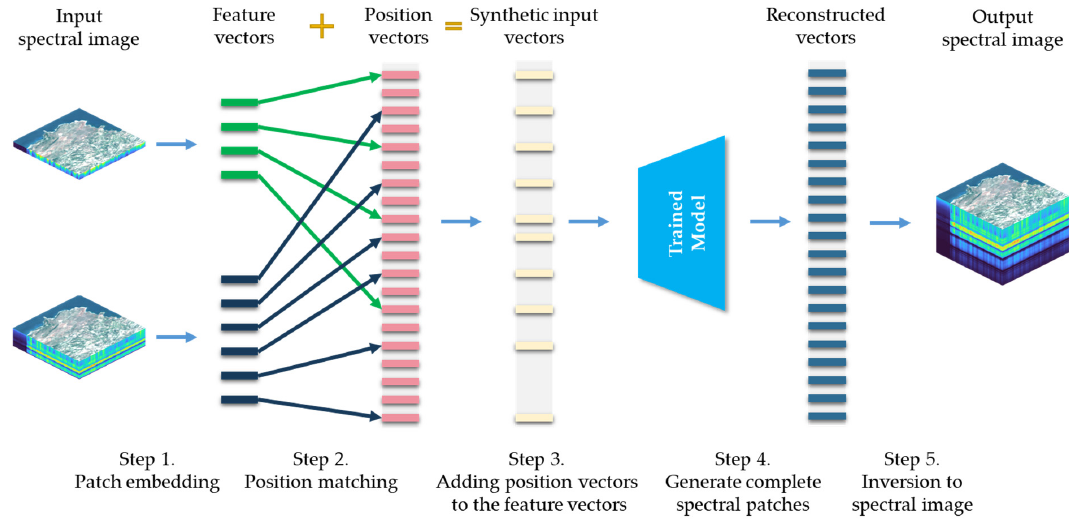
Figure 6. The specific steps of applying the SpectralMAE model, demonstrated using Case 3 in Figure 2 as an example. Two input spectral images with different spectral coverage from two sensors are fused and reconstructed to obtain an image with higher spectral resolution.